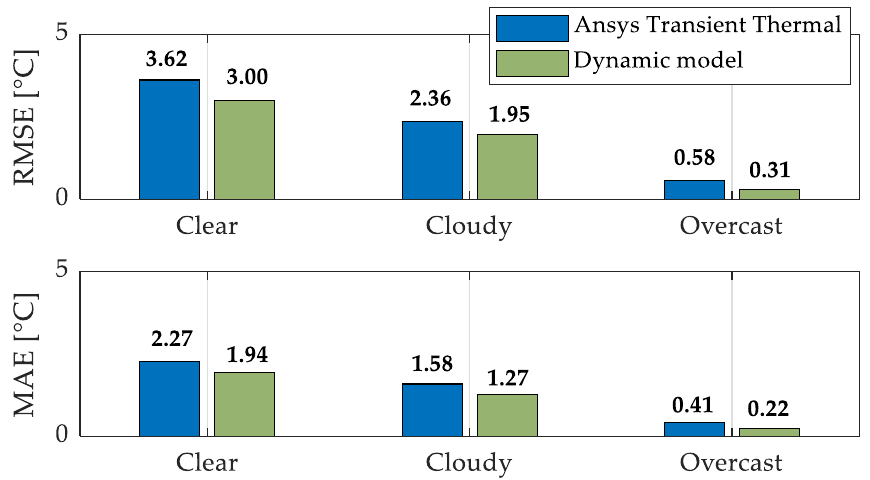
Figure 6. Comparison of static and dynamic thermal models for RMSE and MAE under different weather conditions.